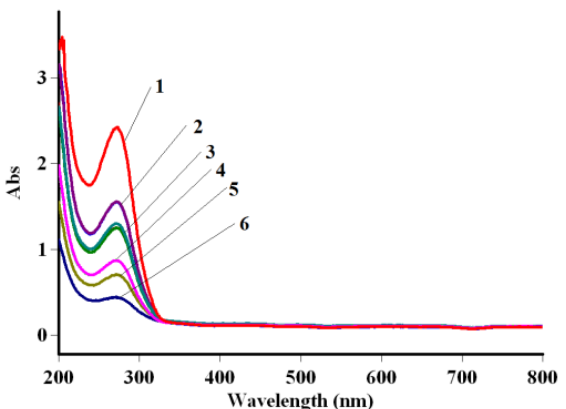
Figure 6. UV-visible absorption spectra of CTX antibiotic before (1) and after extraction for 5 (2), 10 (3), 15 (4), 30 (5) and 45 (6) min.